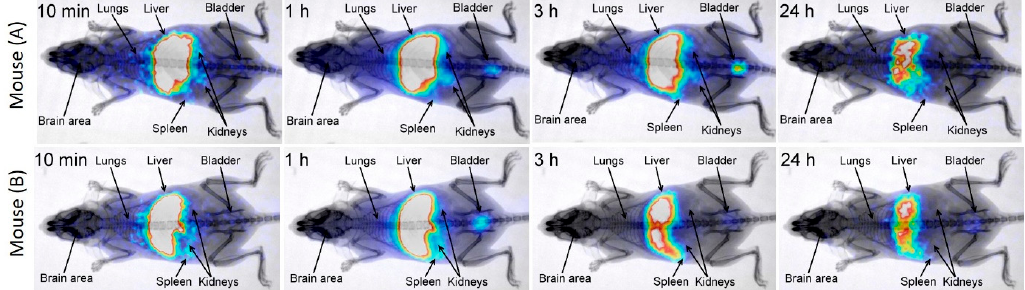
Figure 3. Static scintigraphy/X-ray images of two healthy Swiss-Webster Albino mice ( A and B ) intravenously injected (i.v.) via the tail vein with 5 μ g of 99m Tc-labeled CNCs (~0.1 mCi) at 10 min, 1 h, 3 h, and 24 h post-injection (p.i.).